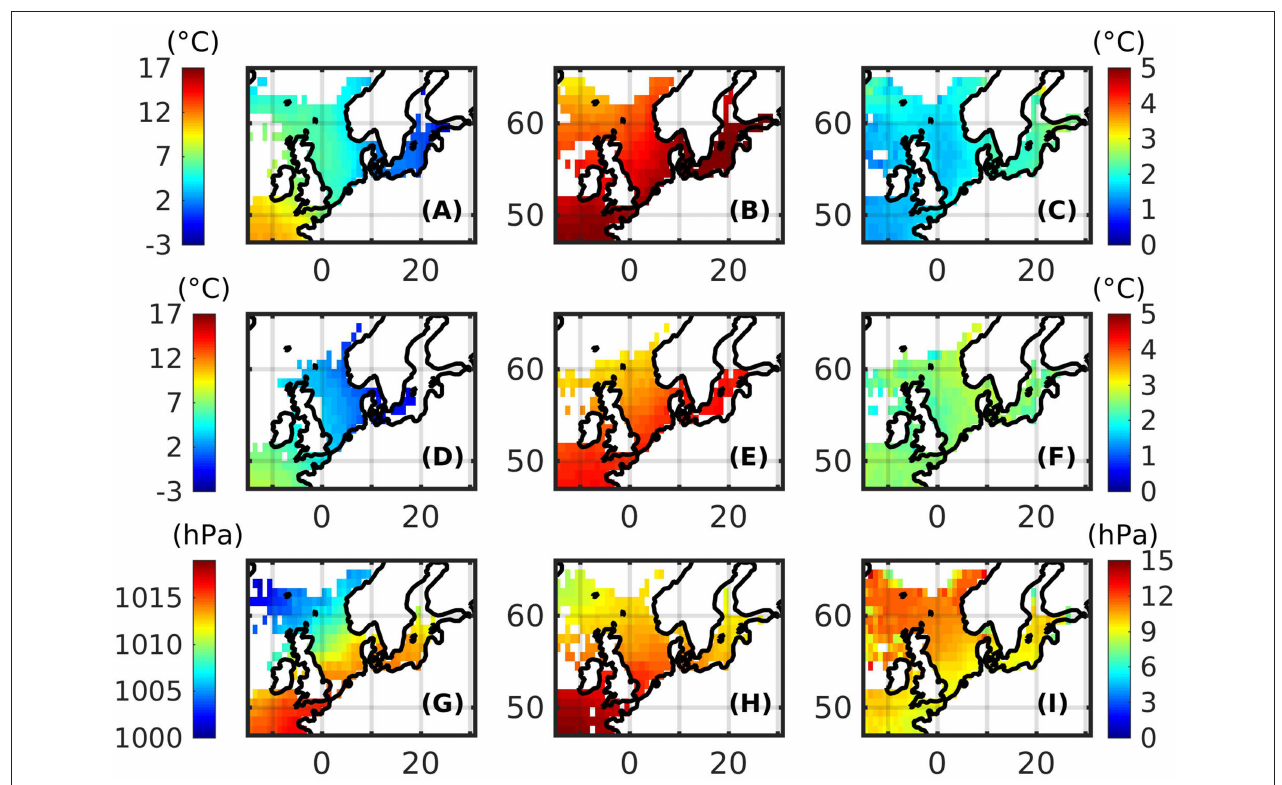
FIGURE 4 | BNSCatm Climatology for 1950 to 2015: means of the parameters 2 meter air temperature (A,B) , 2 m dew point temperature (D,E) , and sea level pressure (G,H) for the months January (A,D,G) and July (B,E,H) and the mean standard deviation of each parameter over the whole period (C,F,I) . Boxes with insufficient data coverage are